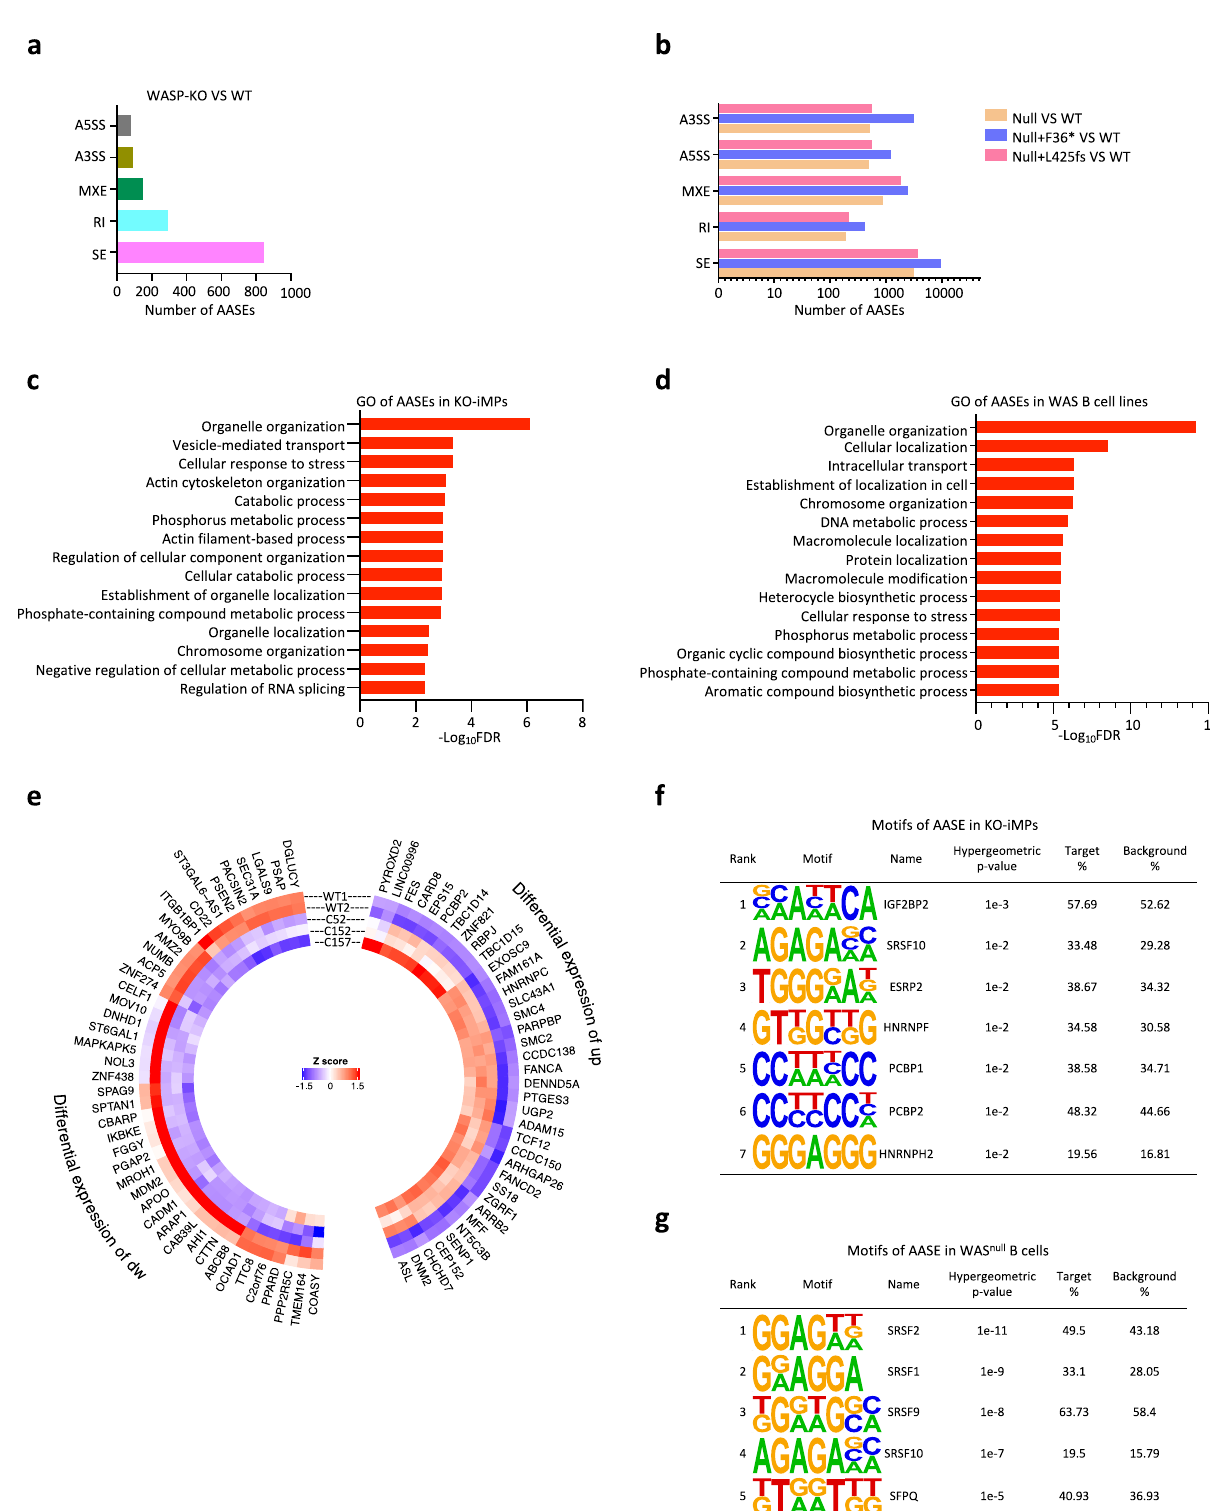
Fig. 4 WASP de fi ciency results in altered RNA splicing in iMPs and B-cell lines. a Altered alternative splicing events (AASEs) in KO-iMPs (three clones). A3SS alternative 3 ’ splicing site, A5SS alternative 5 ’ splicing site, MXE multi-exon skipping, RI intron retention, SE exon skipping. WT iMP biological replicate n = 2, KO-iMP biological replicate n = 3. b AASEs in 3 WASP mutant B-cell lines. Biological replicate n = 2. c GO enrichment of AASEs in KO- iMPs. WT-iMP biological replicate n = 2, KO-iMP biological replicate n = 3. d GO enrichment of common AASEs in three WASP mutant B-cell lines. Biological replicate n = 2. Hypergeometric testing P values are corrected for multiple testing using a false discovery rate (FDR). e AASEs in both upregulated genes and downregulated genes in KO-iMPs. up upregulated genes, dw downregulated genes. f Splicing-factor motif analysis of altered SE, RI, and MXE events in KO-iMPs. g Splicing-factor motif analysis of the downstream exon of altered SE in WAS null B cells.